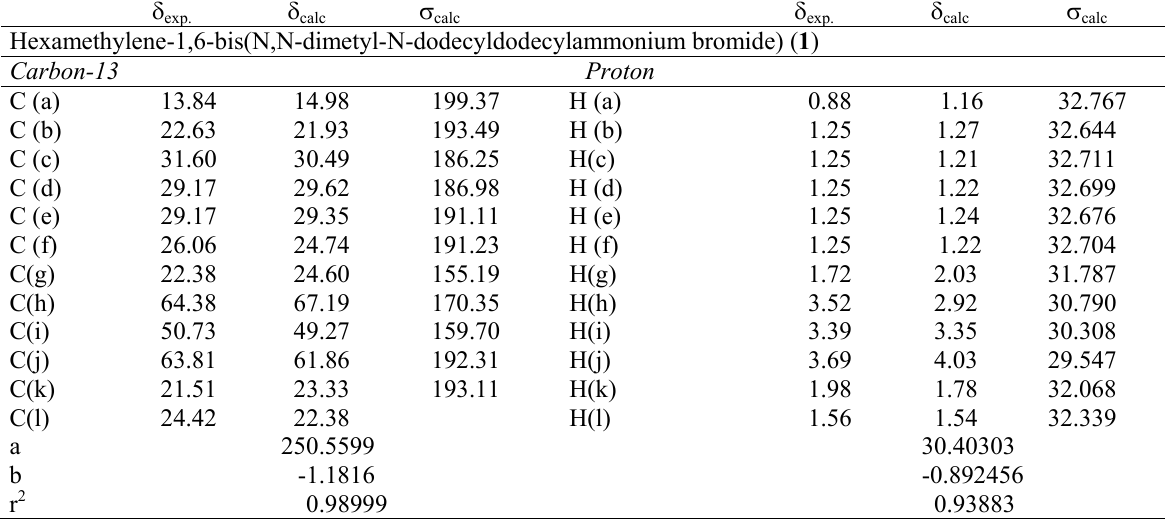
Cl calculating GIAO nuclear magnetic shielding Table 2. Chemical shifts ( δ , ppm) in CD 3 ) for hexamethylene-1,6-bis( N,N -dimethyl- N -dodecylammonium bromide) ( 1 ) tensors ( σ calc and ethylene-1,2-bis( N,N -dimethyl- N -dodecylammonium bromide) ( 5 ). The predicted = a + b· σ with a and GIAO chemical shifts were computed from the linear equation δ exp. calc b determined from the fit the experimental data ( r is the correlation